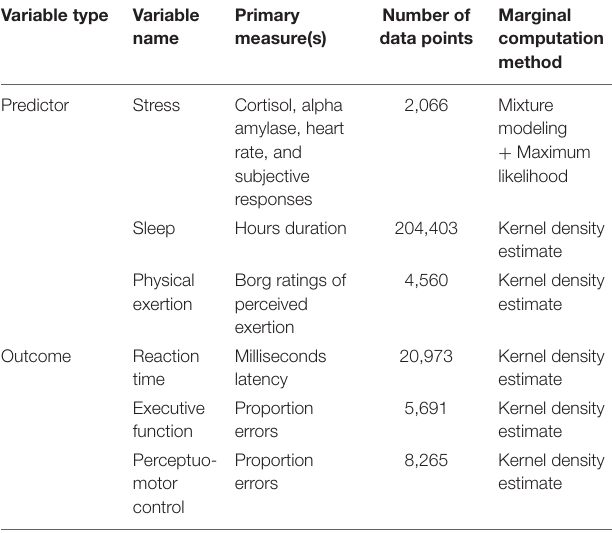
TABLE 2 | The six variables of interest, including three predictors and three outputs, their primary methods of measurement, and the number of data points used to estimate each variable’s